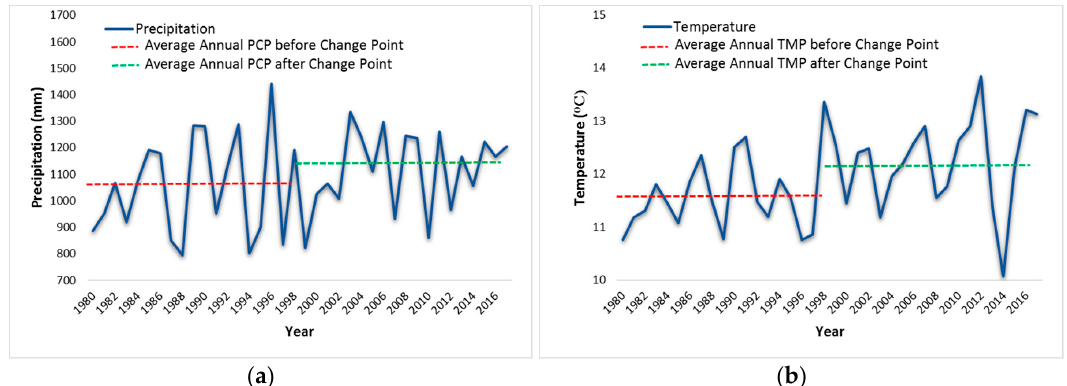
Figure 4. Annual precipitation ( a ) and temperature ( b ) in the LEC watershed.